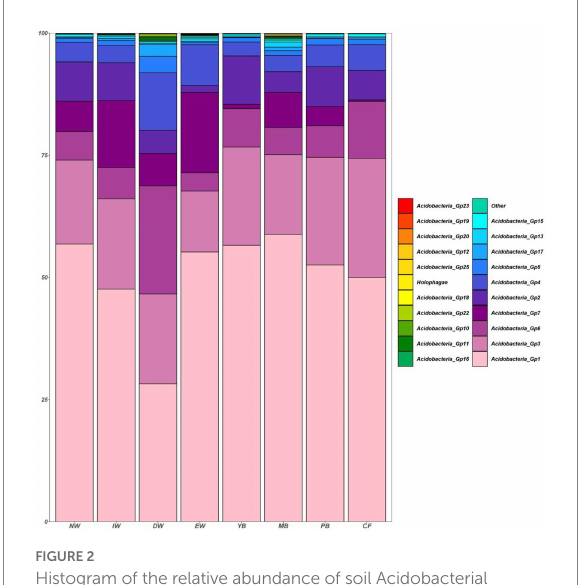
FIGURE 2 Histogram of the relative abundance of soil Acidobacterial communities in a degraded wetland.